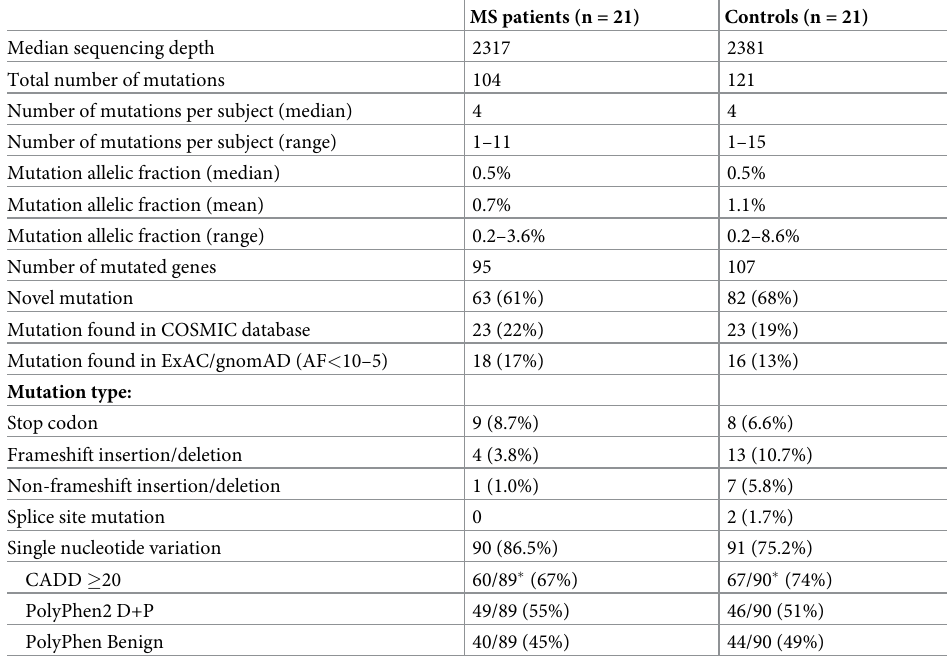
Table 2. Comparison of the discovered nonsynonymous somatic mutations in genes expressed in CD8+ cells in MS patients and